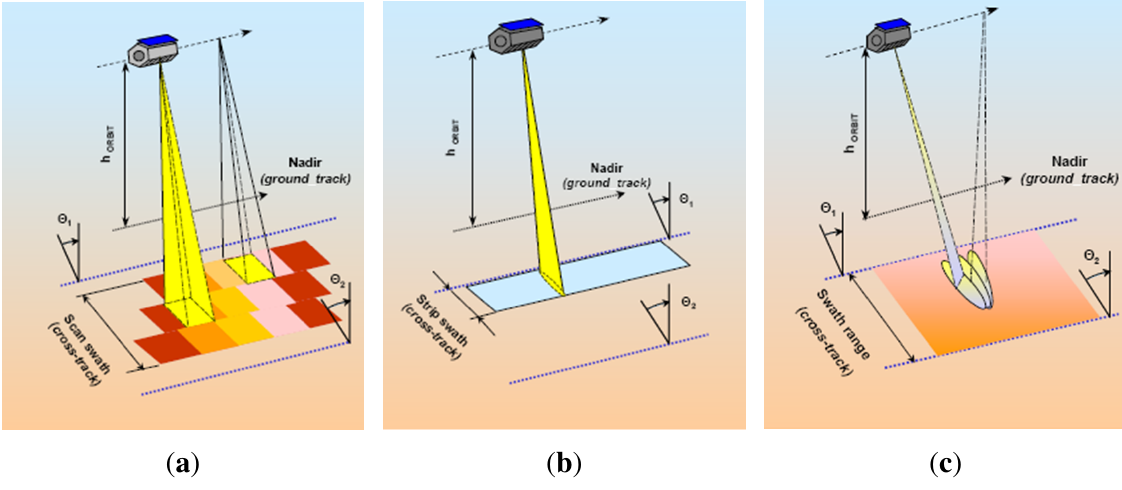
Figure 14. PAZ imaging models [8]: ScanSAR ( a ); stripmap ( b ); spotlight ( c